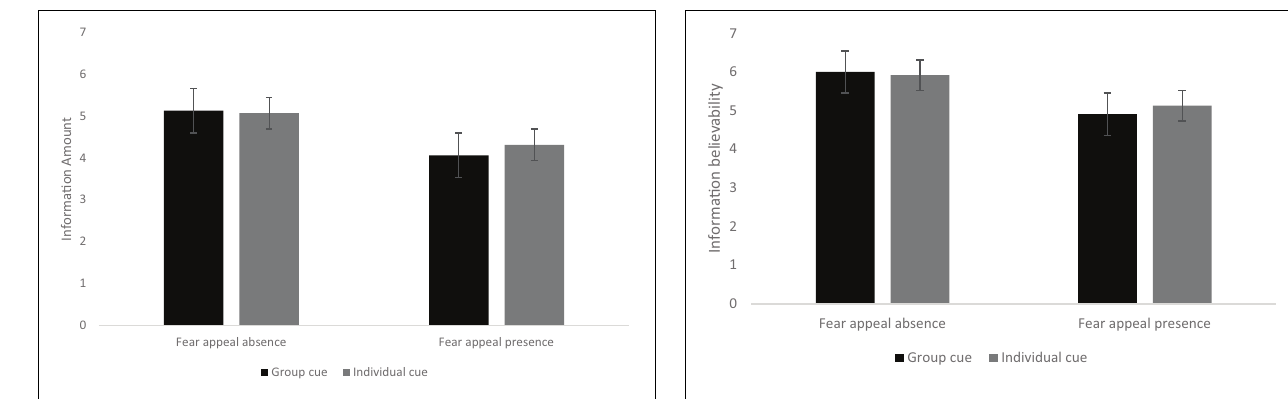
between posters with group cues and individual cues ( F < 1, p = 0.35).